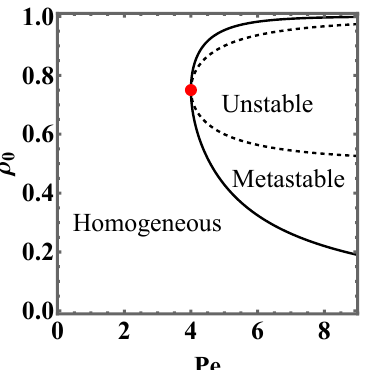
Figure 2: The phase diagram of the model. The binodal is denoted by a solid black line and the spinodal by a dashed line. They meet at ( ρ the critical point (red circle). In a MIPS state, the high- and low-density coexisting phases lay on the